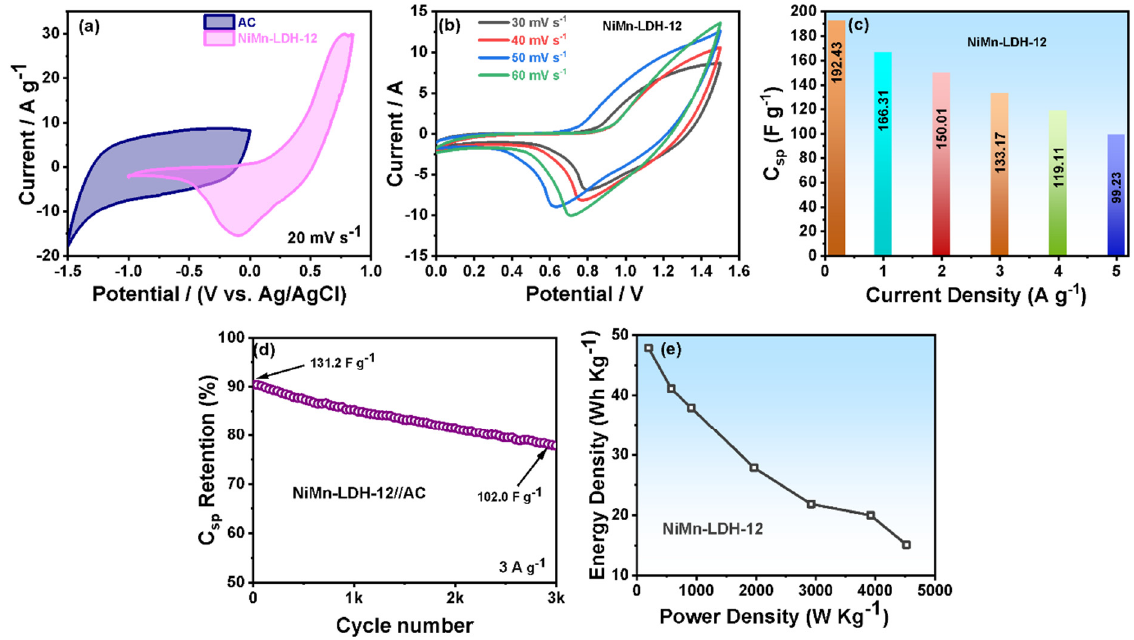
Figure 6. ( a ) CV curve of AC and NiMn-LDH-12 with overlapping potential window; ( b ) CV profile of NiMn-LDH-12//AC at different scan rates in a fixed potential window of 0 to 1.5 V; ( c ) specific capacitance of resulting ASC device at different current densities; ( d ) cycling stability measurement at 3000 cycles at constant current density under the potential window of 0 to 1.5 V and; ( e ) the plot of energy and power density of the constructed ASC device.